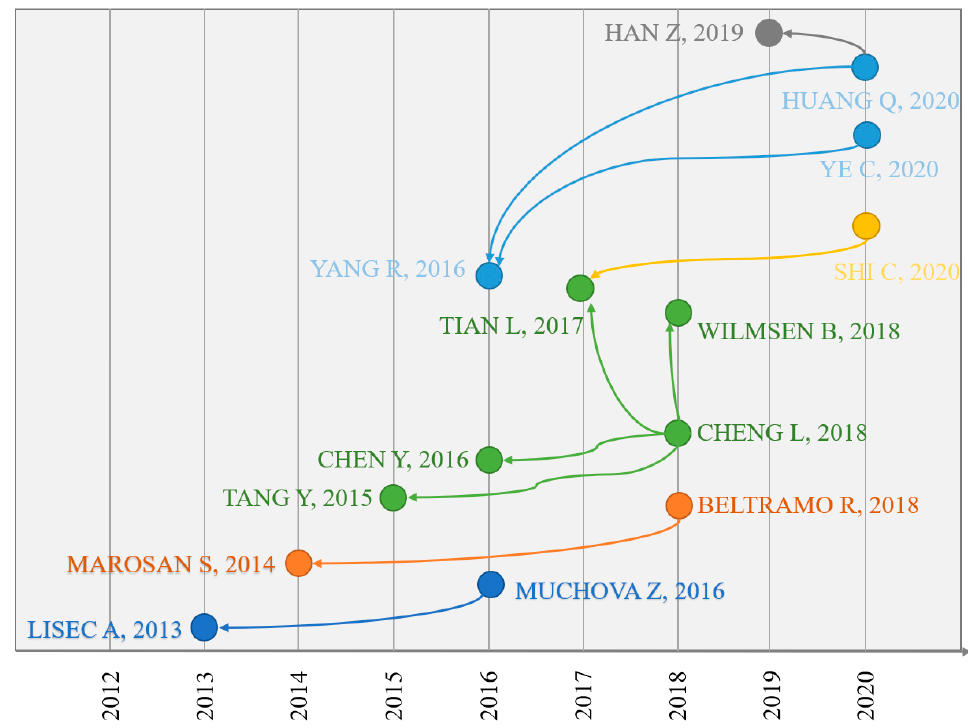
Figure 6. The historical direct citation network of the top 10 cited papers in the field of land consolidation and rural revitalization from 1950 to 2021.